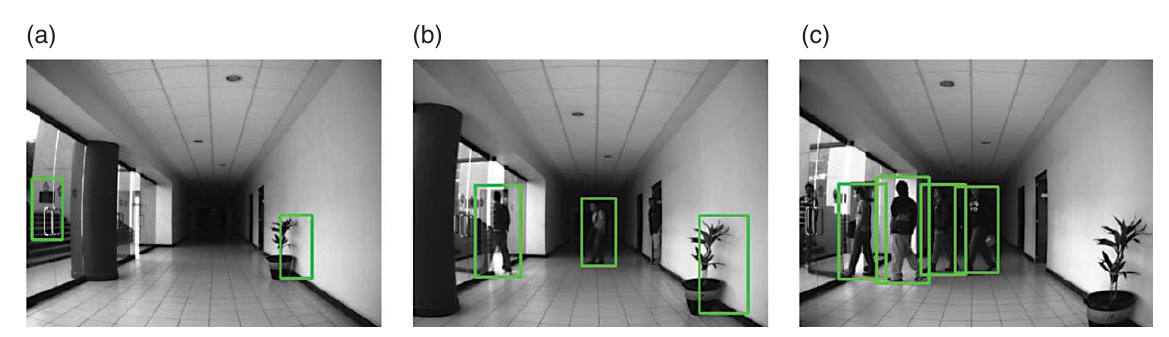
Fig. 13. Detection of a sequence of arbitrary contours based on HOG and a SVM classifier. (a) (left) A door handle and a plant are detected; (b)(middle) plant, person approaching, and one leaving; (c) (right) a group of students